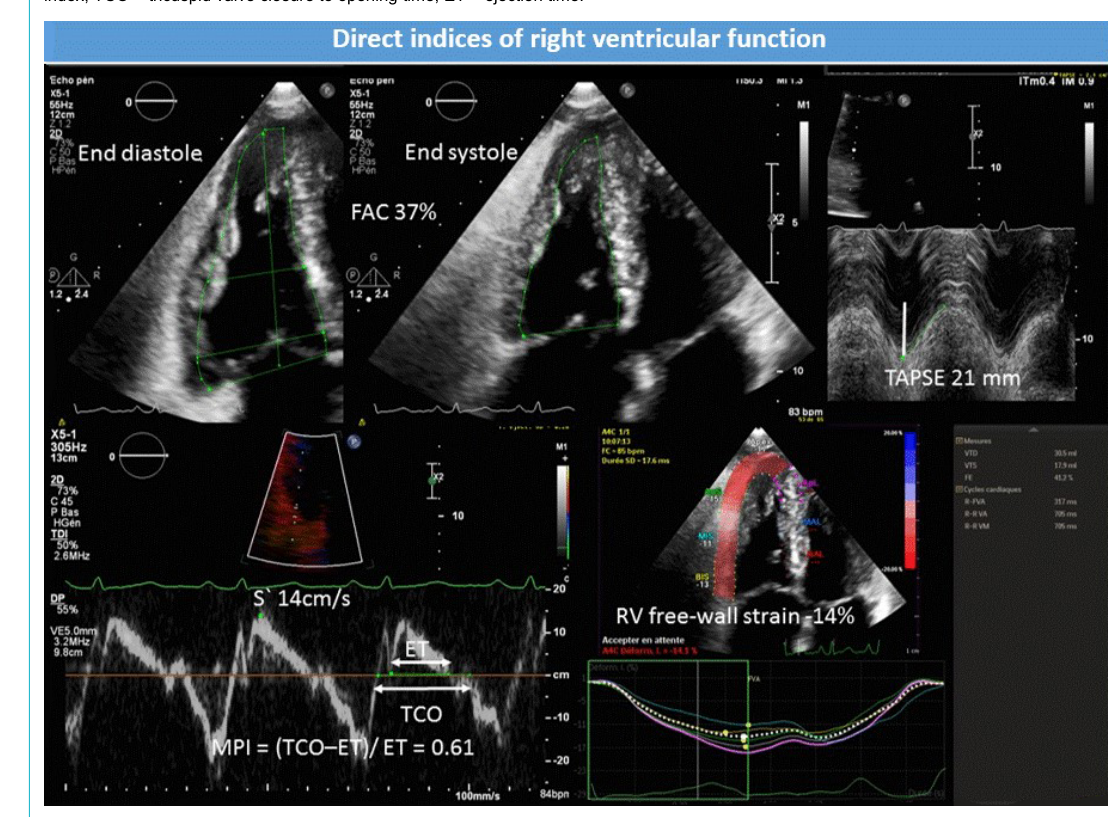
Figure 4: 76-year-old male with pulmonary arterial hypertension. Normal TAPSE, S′ velocity and FAC with abnormal MPI and right ventricular free-wall strain. FAC = fractional area change; TAPSE = tricuspid annular plane systolic excursion; S′ = TA tissue Doppler velocity; MPI = Tei index; TCO = tricuspid valve closure to opening time; ET = ejection